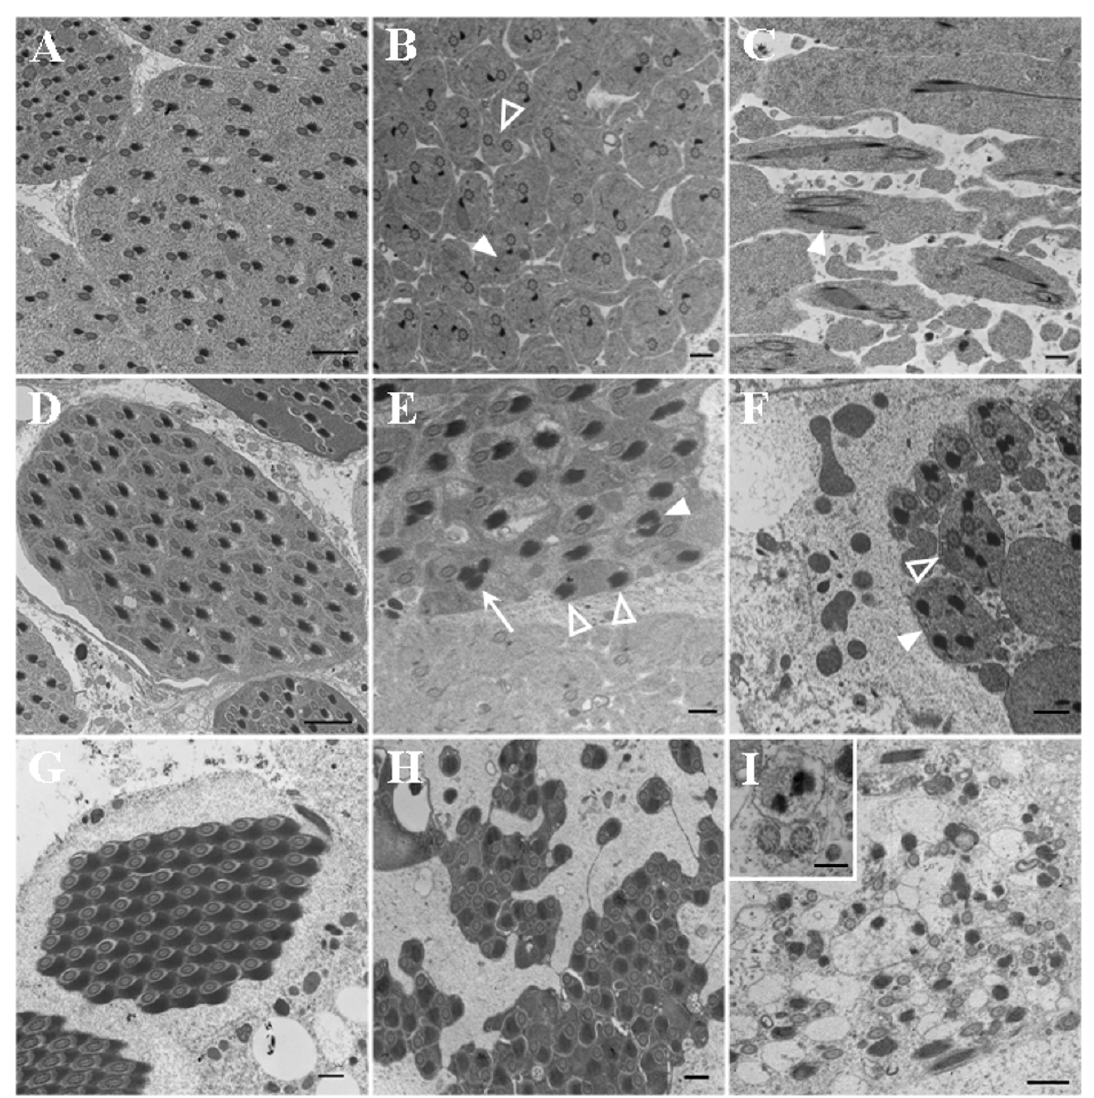
Figure 6 Ultrastructural analysis of the control and Merlin mutant cysts during the elongation and individualization stages. (A-C) Sec- tions of the cysts from the control FM6 (A), Mer 3 (B), or Mer 4 (C) testis at the elongation stage. (A) A dark paracrystalline body was seen within the major mitochondrial derivative in the control spermatid. Bar = 2 µ m. (B) Some of the spermatids in the Mer 3 cyst contained two paracrystalline bodies (filled arrowhead points to one example). Also, some spermatids had two axonemes (open arrowhead). Bar = 0.5 µ m. (C) Two paracrystalline bodies within the major mitochondrial derivative were frequently seen in the elongating spermatids of the Mer 4 cyst. Bar = 0.5 µ m. (D-F) Cysts from the control FM6 (D), Mer 3 (E), or Mer 4 (F) testis at the individualization stage. (D) The association of axoneme with the mitochondrial derivatives was seen in the spermatids of the control cyst. Bar = 2 µ m. (E) Spermatids in the Mer 3 cyst might contain two abnormally-shaped (filled arrow- head) or three (arrow) paracrystalline bodies together with one axoneme, or have two paracrystalline-filled Nebenkerns but without the axoneme (open arrowhead). Bar = 0.5 µ m. (F) Spermatids with multiple Nebenkerns with (open arrowhead) or without (filled arrowhead) axonemes together with cytoplasmic fragmentation were seen in the Mer 4 cyst. Bar = 0.5 µ m. (G-I) Cysts from the control FM6 (G), Mer 3 (H), or Mer 4 (I) testis at the late stage of individualization. (G) Individualized spermatids in the control cyst displayed a highly-ordered axoneme-Nebenkern pair. Bar = 0.5 µ m. (H) The spermatids in the Mer 3 cyst were poorly arranged and some of them appeared to be fused together. Bar = 0.5 µ m. (I) The Mer 4 cyst showed a complete destruction of spermatid individualization, resulting in empty spermatids with or without axoneme or Nebenkern. Insert illus- trates the structure of axoneme appeared to be intact. Bar = 1 µ m. Bar in the insert = 0.2 µ